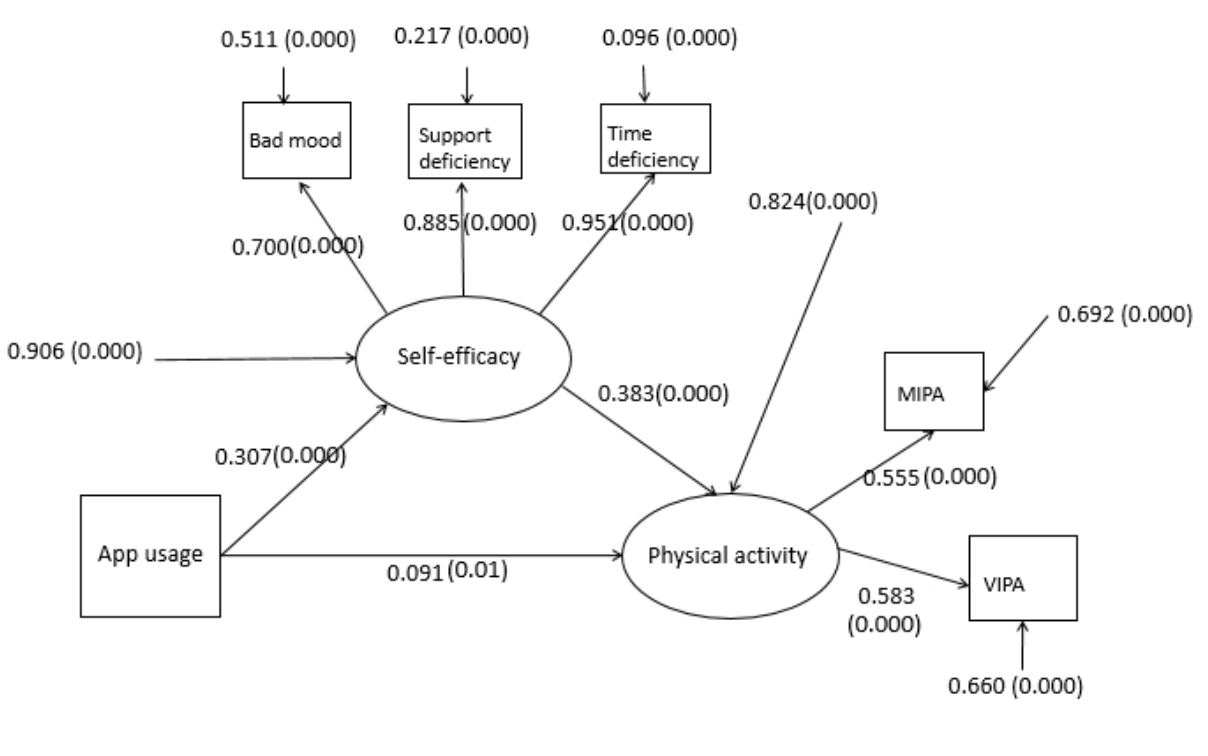
Figure 2. Single mediation model, in which app-usage is a three-level categorical predictor (current users=3, past users=2, and non-users=1). Self-efficacy is described by bad mood, support deficiency, and time deficiency; VIPA is vigorous-intensity physical activity and MIPA is moderate-intensity physical activity. (0.000) represents significant path coefficients at the .001 level and (0.01), at the .05